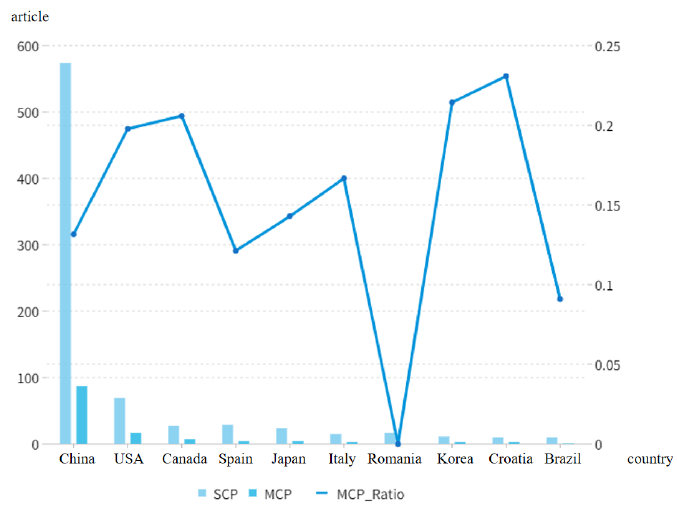
Figure 6. Publication cooperation of some countries in the field of rural revitalization from 1991 to 2021. Note: SCP refers to the amount of papers independently published in the country; MCP refers to the number of jointly published papers in the country; ratio indicates the percentage of joint publications in the country as a percentage of total publications.